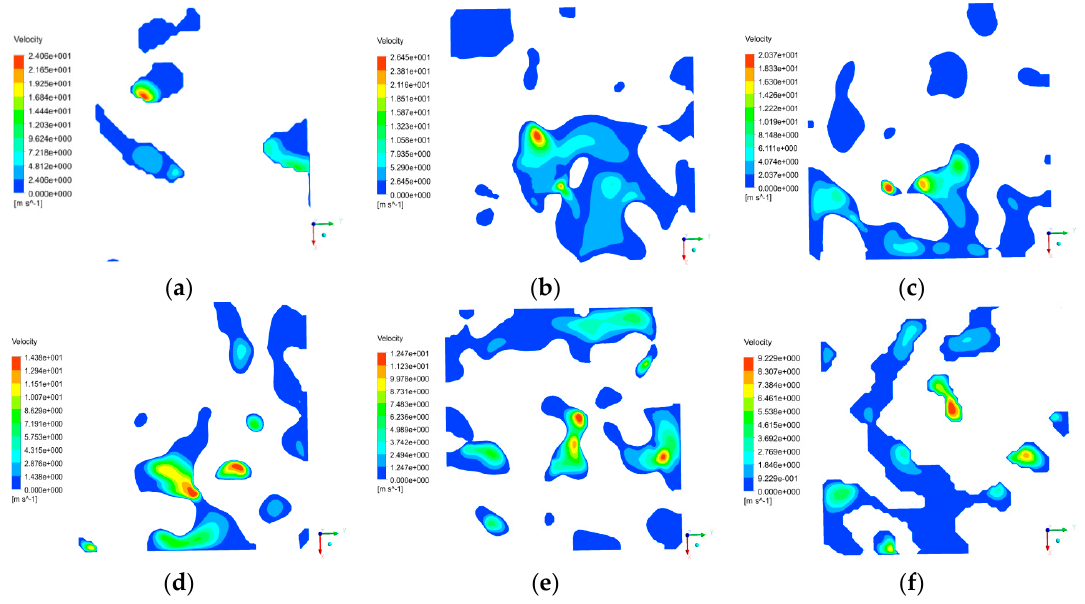
Figure 14 . Water seepage velocity distribution of different sections of the single channel in the Z direction: ( a ) x = 0 μ m; ( b ) x = 12 μ m; ( c ) x = 24 μ m; ( d ) x = 36 μ m; ( e ) x = 48 μ m; and ( f ) x = 60 μ m.